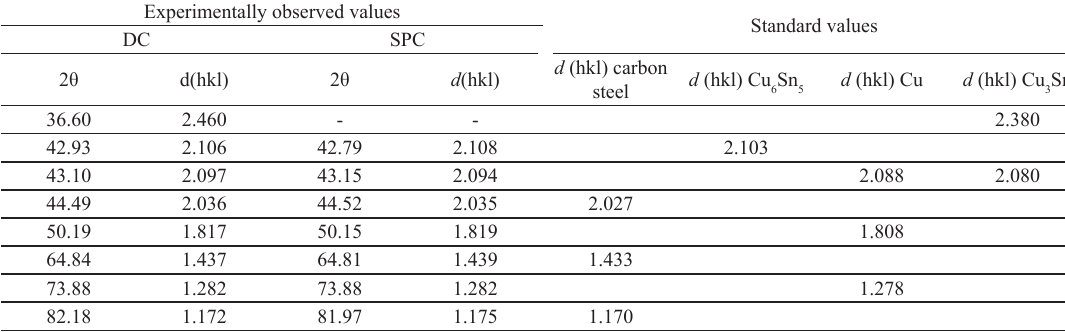
Table 4. d (hkl) values for the Cu-Sn coatings produced by DC and SPC electrodeposition processes. Experimentally observed values